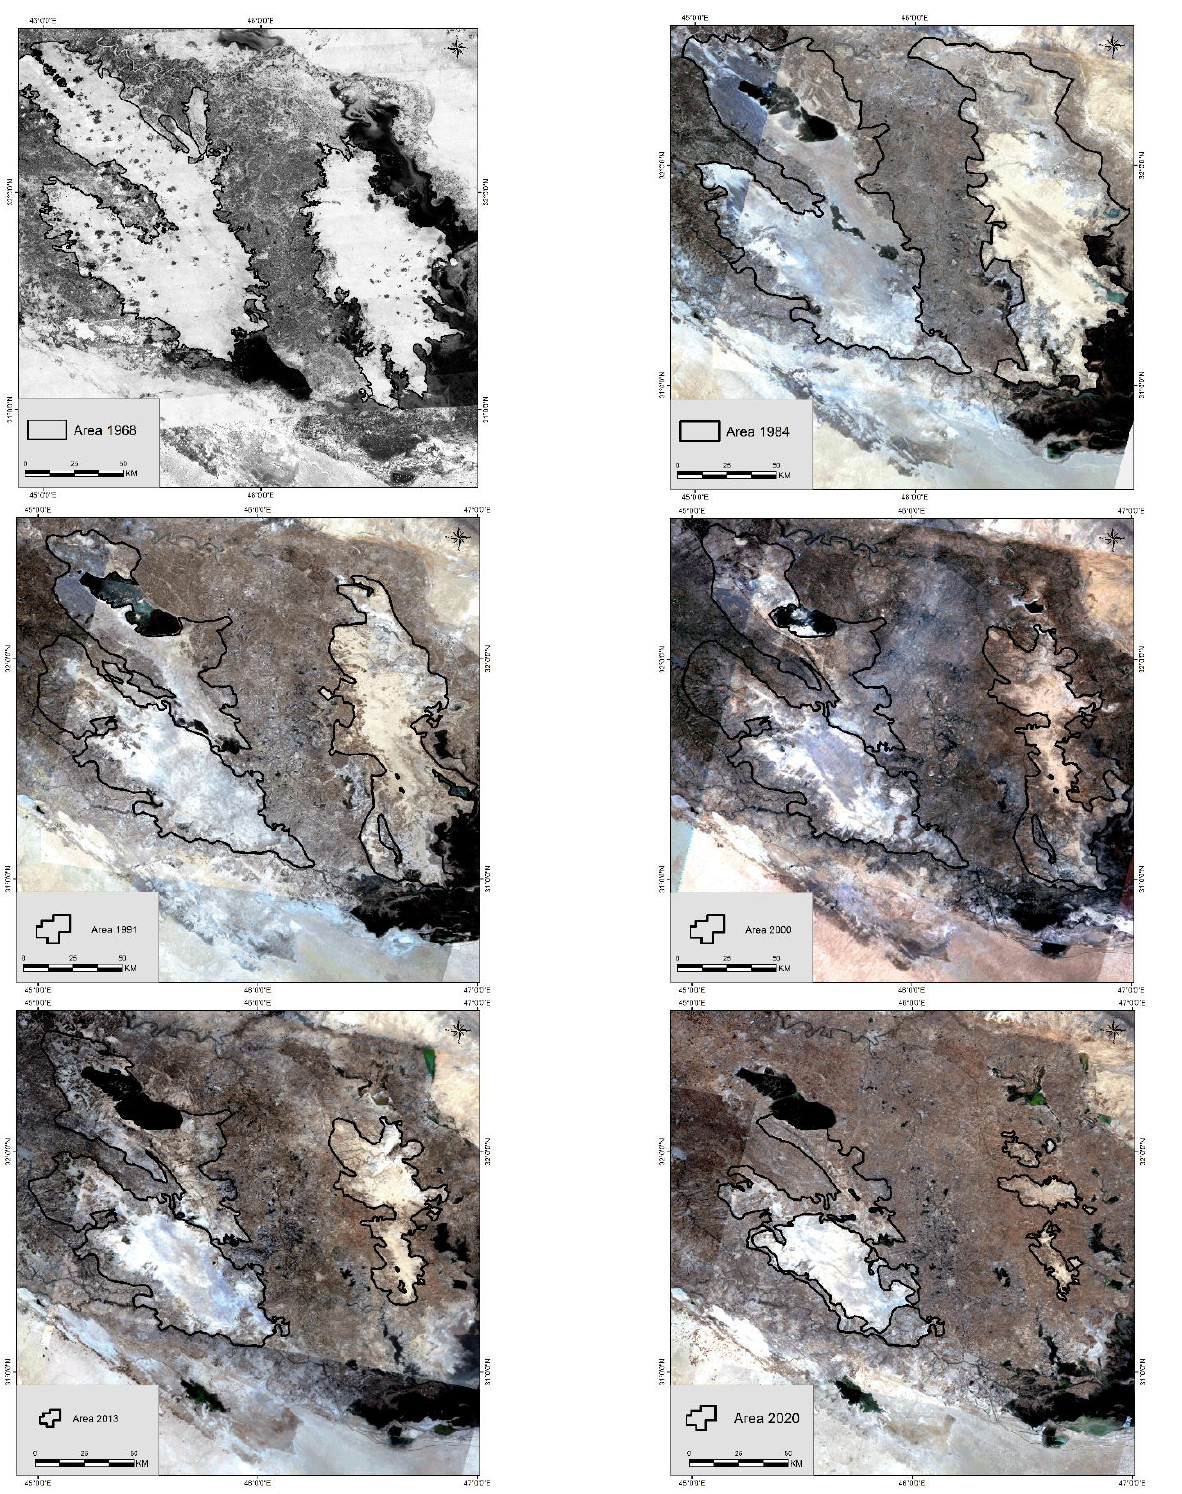
Figure 11. The two studied hotspot areas using Corona Satellite imagery, on 5 May 1968, and Landsat Satellite imagery, on 1984, 1991, 2000, 2013, and 2020.